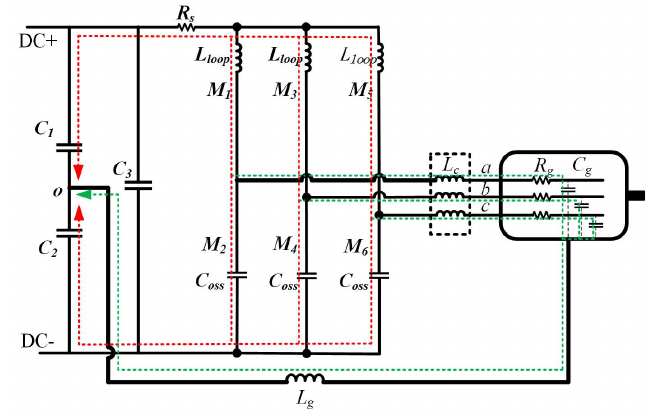
Figure 18. CM propagation path of the HF components in motor